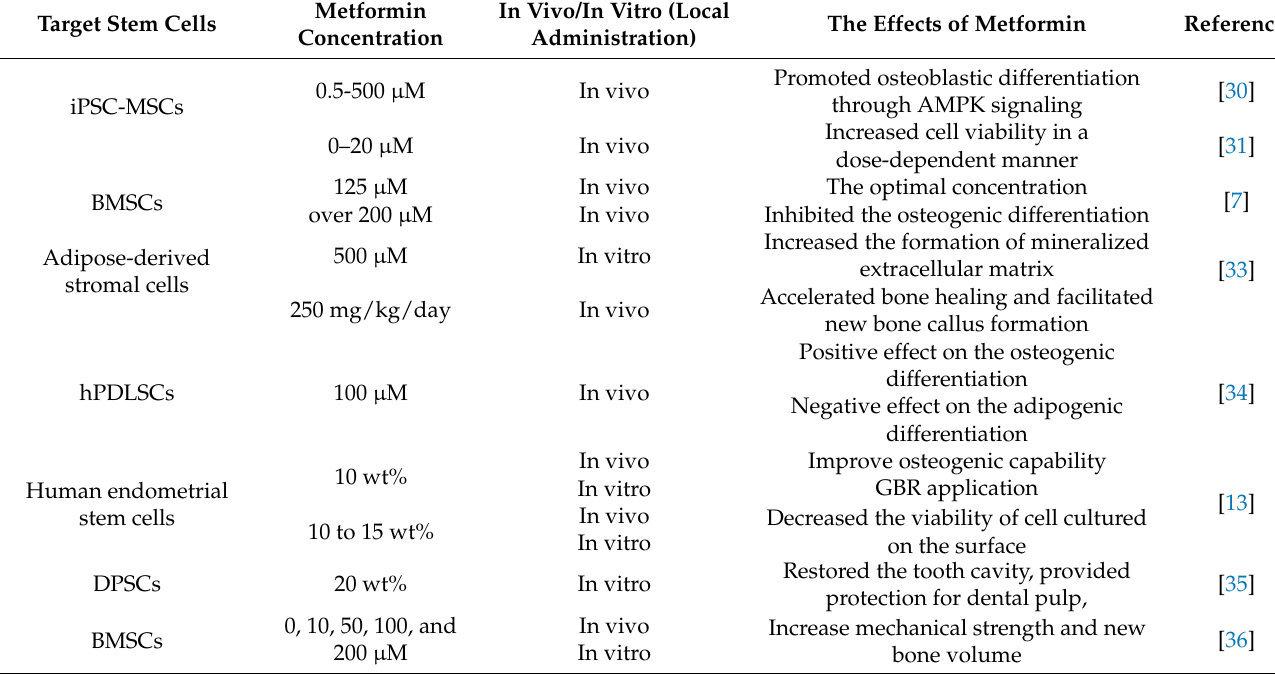
Table 1. Effects of metformin concentration on different target stem cells.